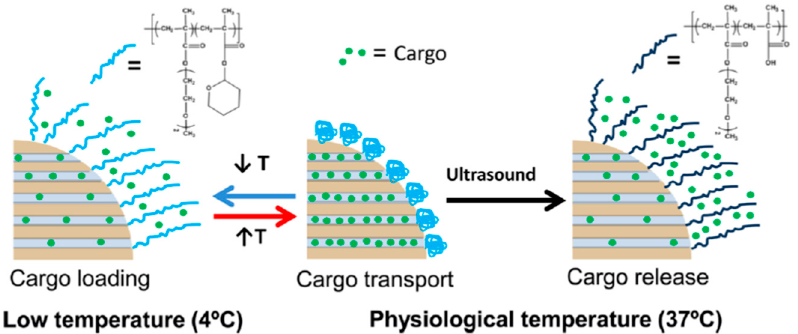
Figure 2. Ultrasound (US)-sensitive polymer coating to control drug-departure in MSN. Polymer shell collapsed at physiological temperature blocking drug departure while adopting an extended conformation under US releasing the payload. Reproduced with permission from [57], American Chemical Society, 2015.